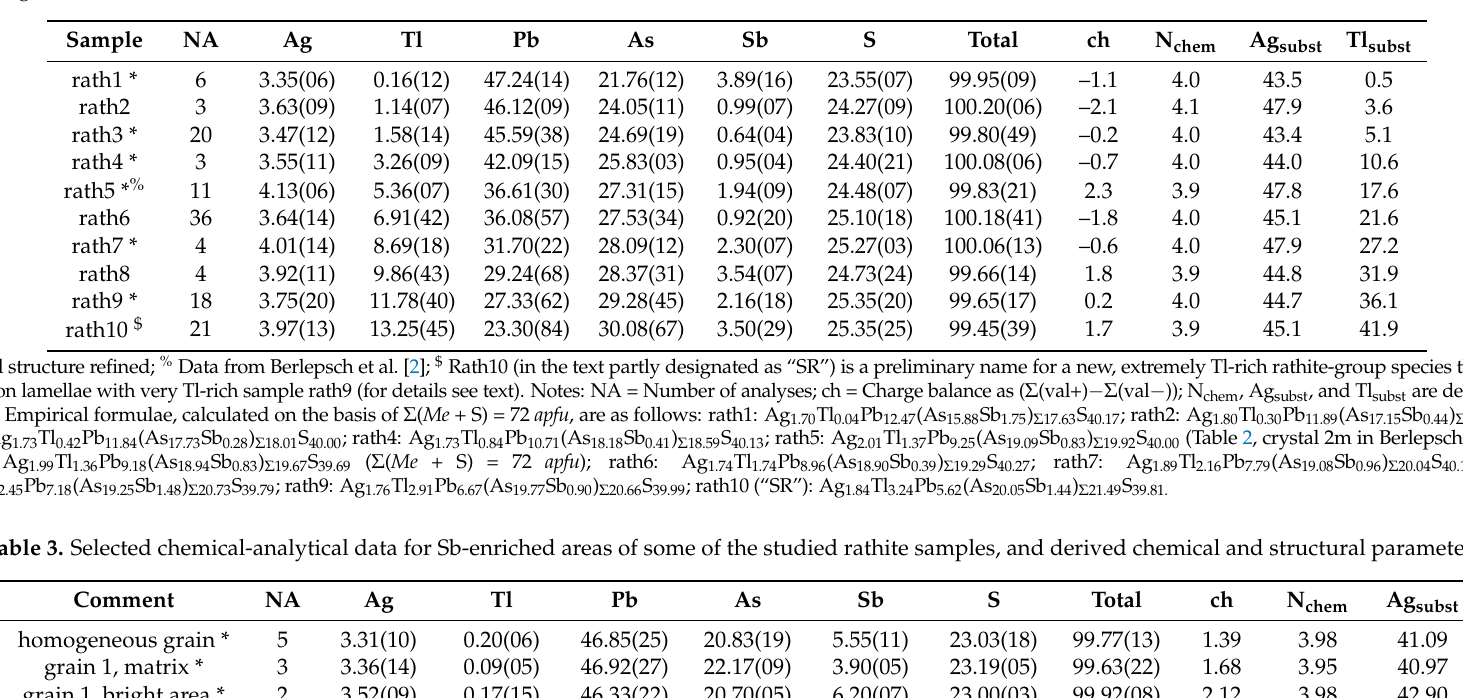
Table 2. Chemical-analytical data and derived chemical and structural parameters for the studied rathite samples (all from Lengenbach), ordered according to increasing Tl contents.